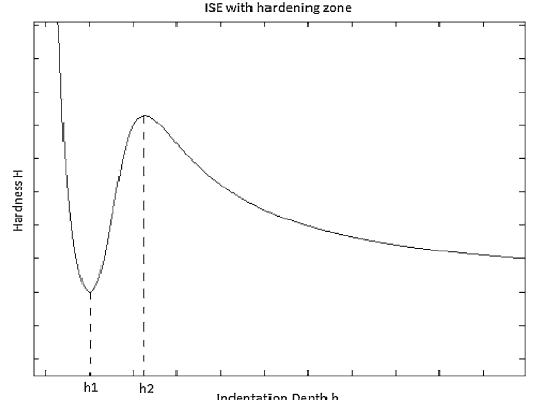
Figure 23. Visualization of the ISE with the incorporated hardening effect. For h < h 1 , hardness decreases, for h 1 < h < h 2 , hardness increases and for h > h 2 , hardness decreases again [62].